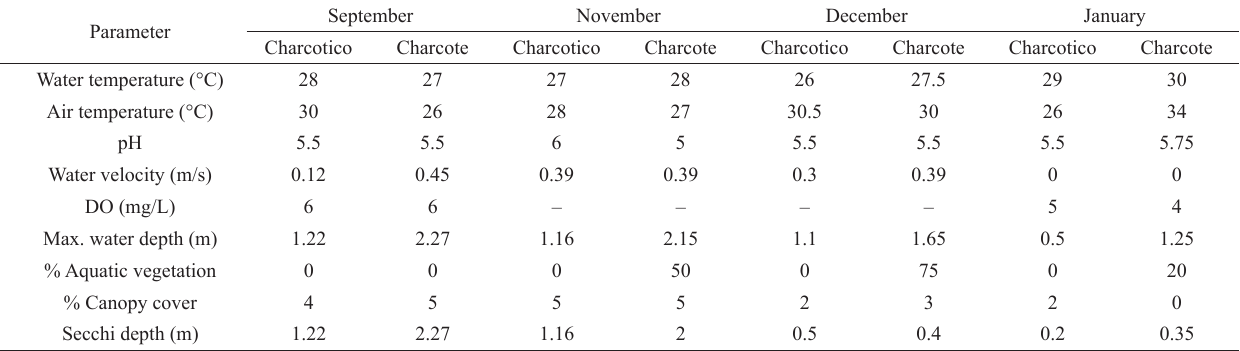
Tab. 1. Physical and chemical characteristics measured for Charcote and Charcotico during four survey periods. DO was not measured during November and December. January was the low-water period, September was near the peak of the annual flood pulse, and during November and December floodwaters were gradually